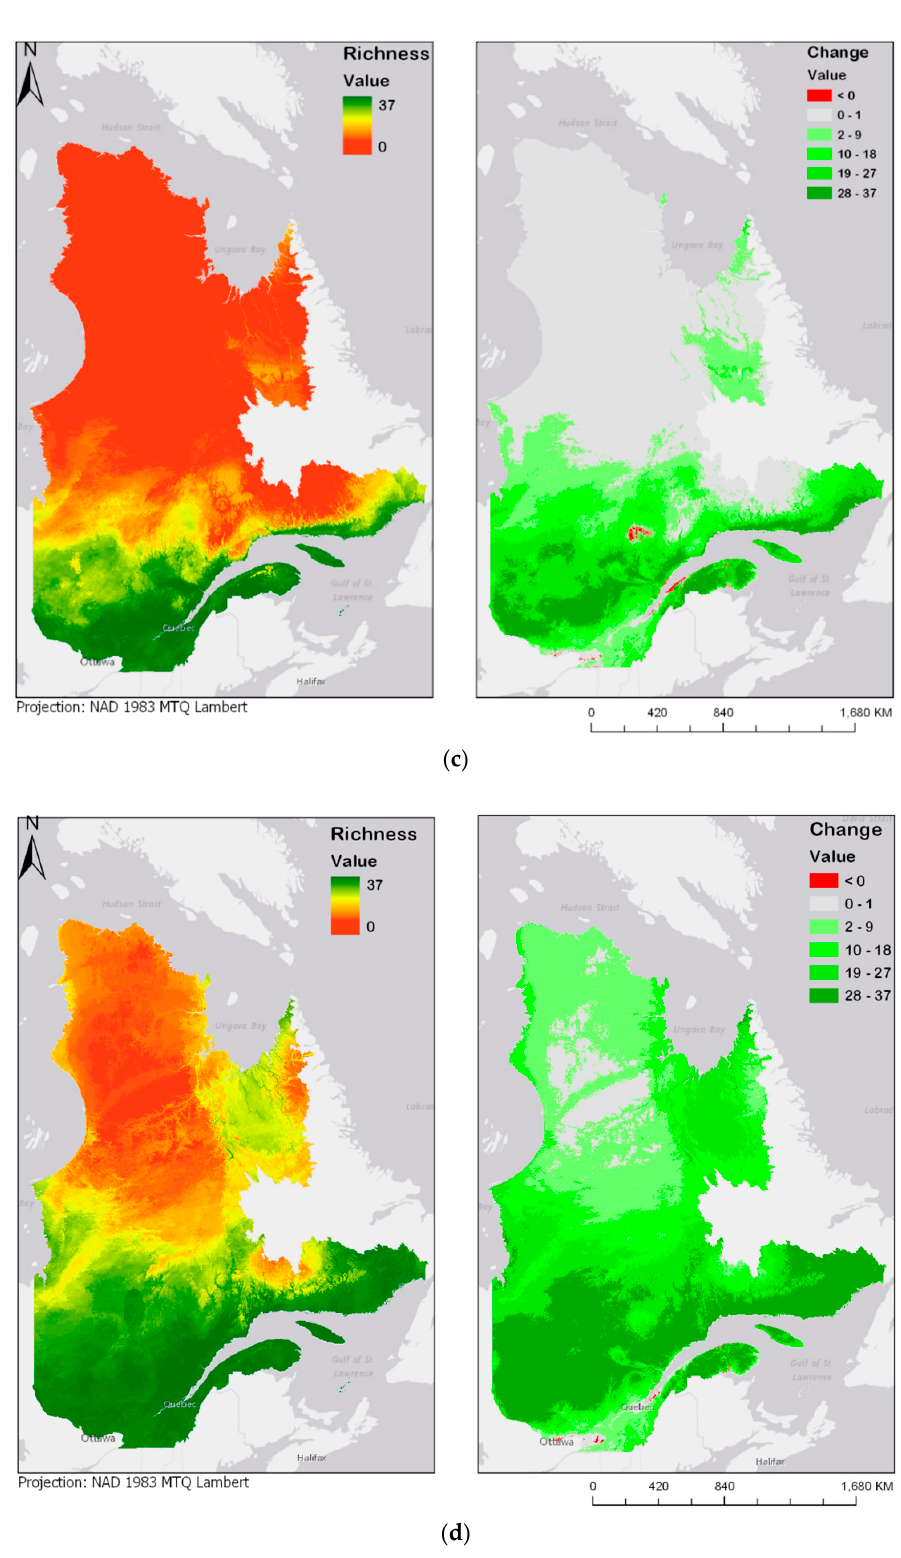
Figure 4. Modeled future bird species richness and change in bird species richness for 2050 and 2070 under two different climate change scenarios: ( a ) year 2050 under the RCP4.5 scenario; ( b ) year 2050 under the RCP8.5 scenario; ( c ) year 2070 under the RCP4.5 scenario; ( d ) year 2070 under the RCP8.5 scenario. Please see Supplementary Materials for the online version of the maps.